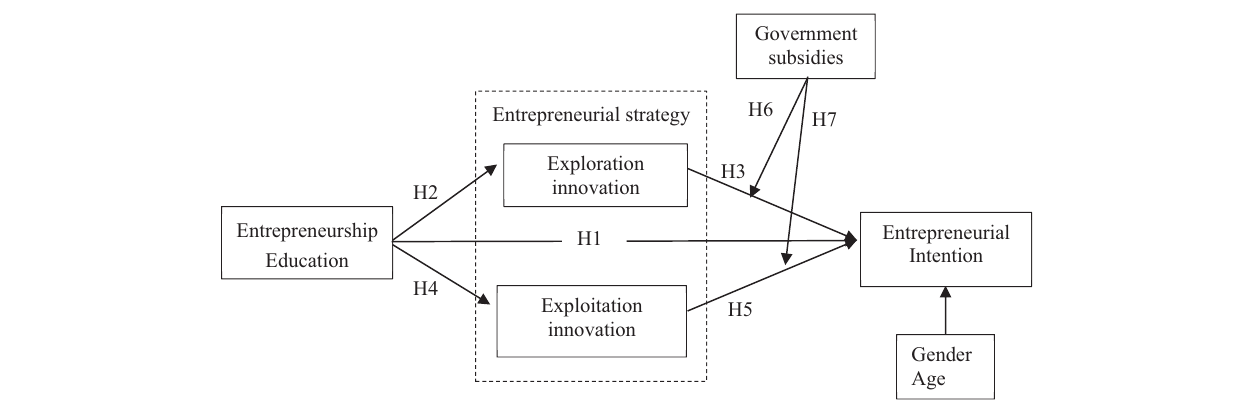
FIGURE 1 | Theoretical conceptual and research framework.